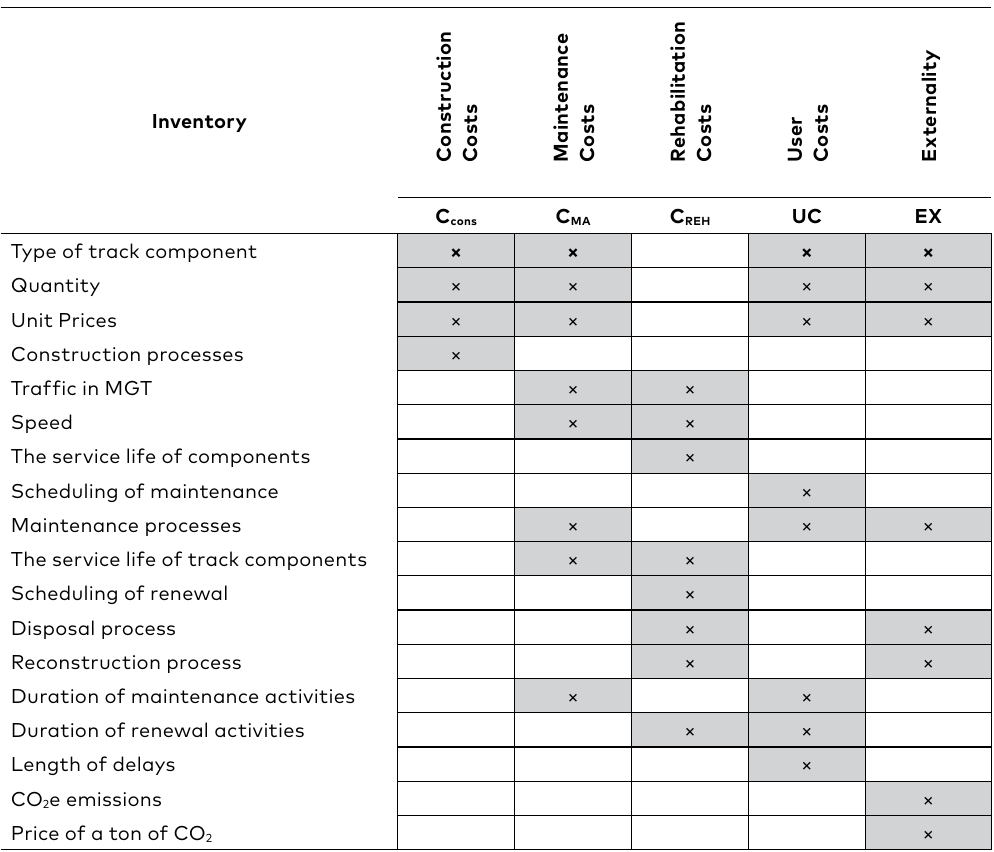
Table 1. Input data for costs